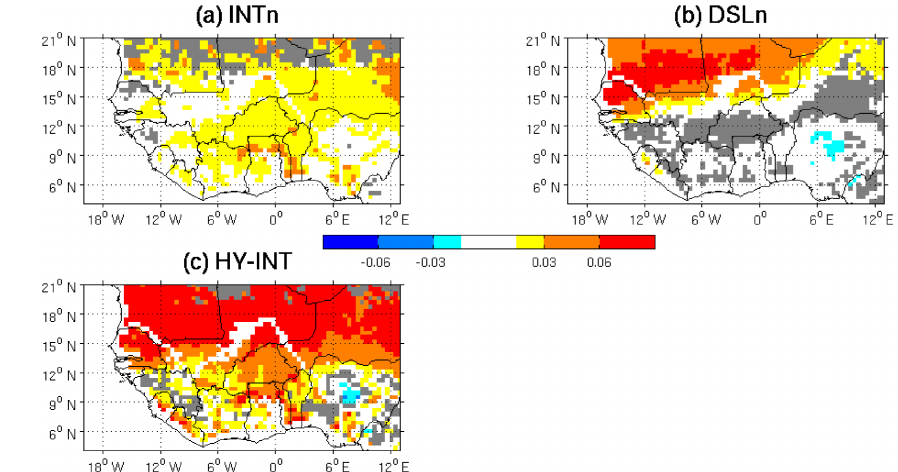
Figure 2. Multimodel mean trend maps (2006–2100) for annual (a) INTn, (b) DSLn, and (c) HY-INT, in units per decade. Trends that are not significant at 95% according to the Student’s t test are shaded in gray.